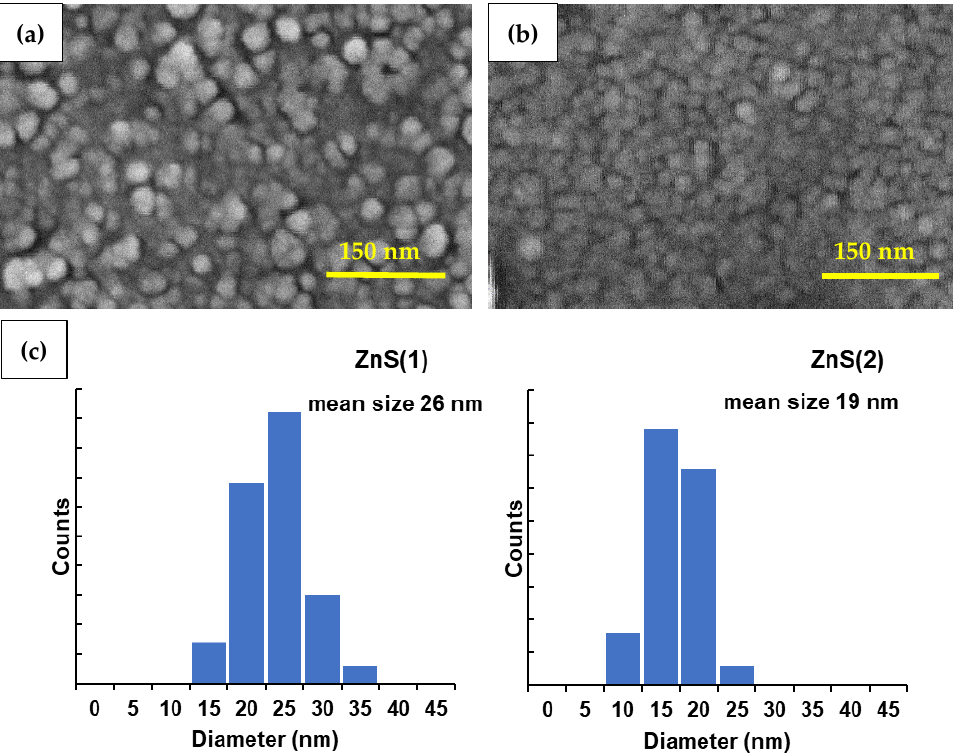
Figure 1. Field-emission scanning electron microscopy (FE-SEM) images of the prepared ZnS NPs: ( a ) sample ZnS(1) prepared using zinc ethylxanthate; ( b ) sample ZnS(2) prepared using zinc amylxanthate; ( c ) Histograms of particle size distribution for samples ZnS(1) and ZnS(2).